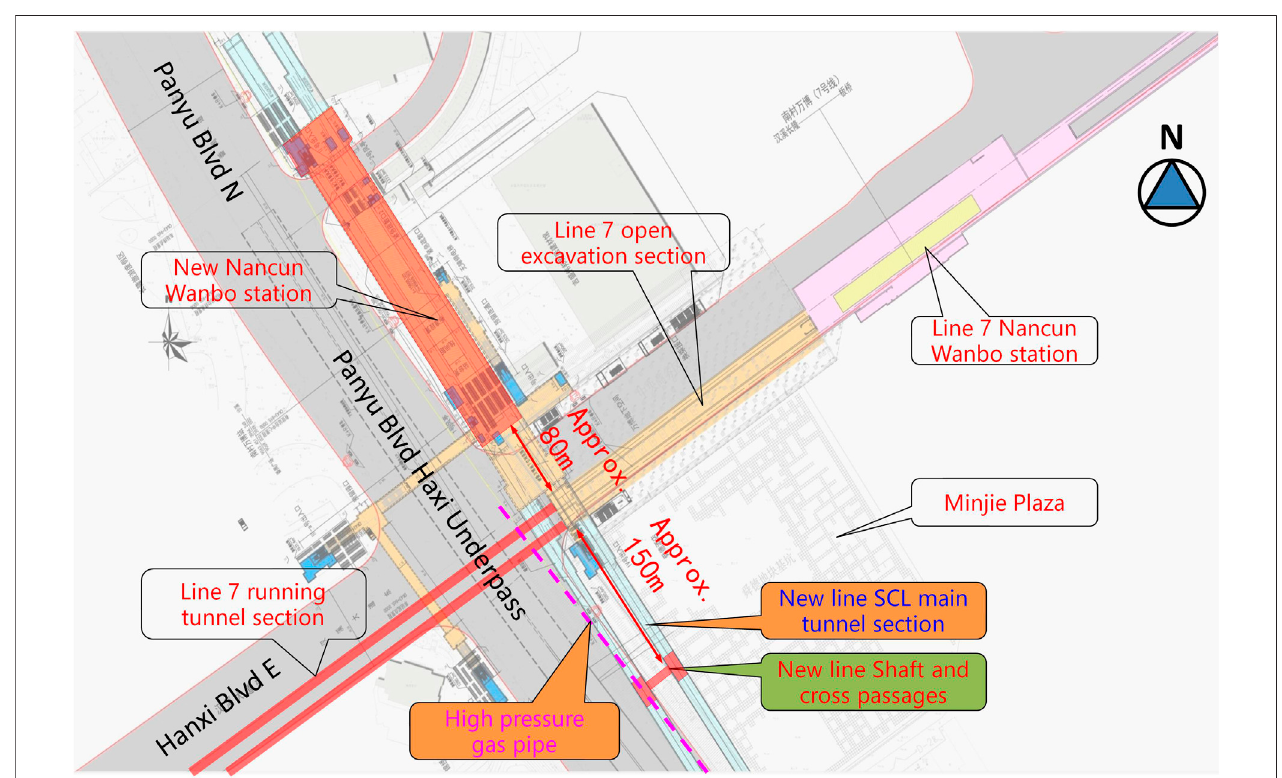
FIGURE 1 | Plan view of areas around the new line construction shaft and cross passages.